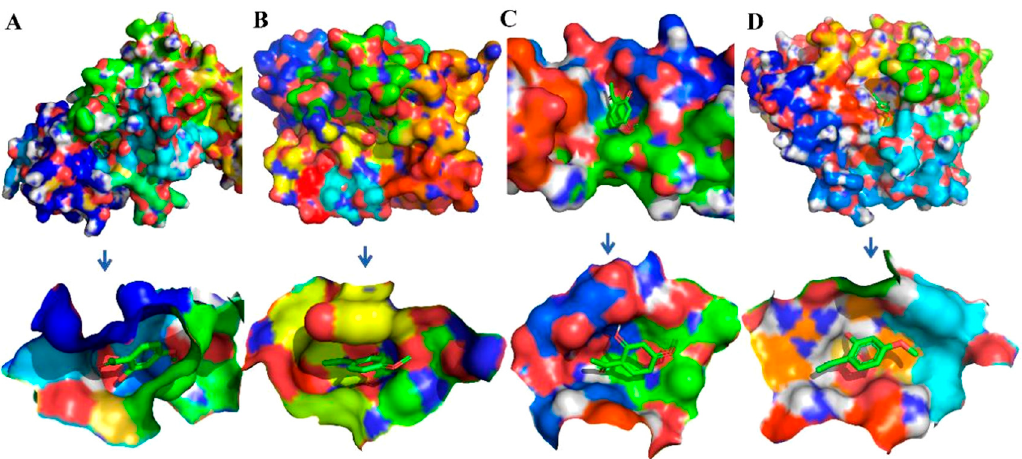
Figure 8. Binding cavity snapshots of Paeonol and four representative receptors. ( A ) ERN1-Serine/threonine-protein kinase/endoribonuclease IRE1. ( B ) PARP1-Poly (ADP-ribose) polymerase-1.